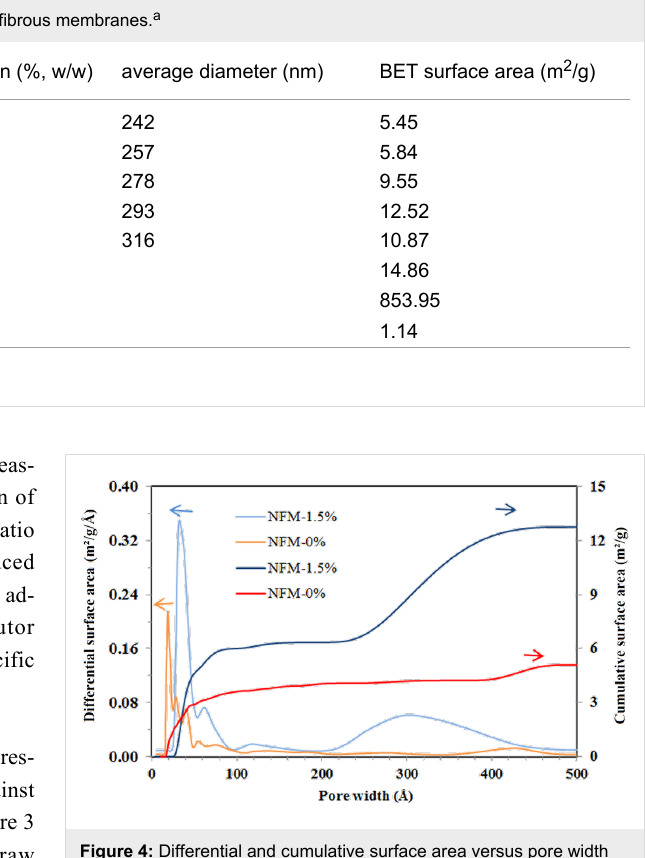
According to the differential surface area curves in Figure 4, NFM-0% had pores in two size ranges of 1.5–10 nm and 38–46 nm and the most probable pore size was 2 nm. Also,